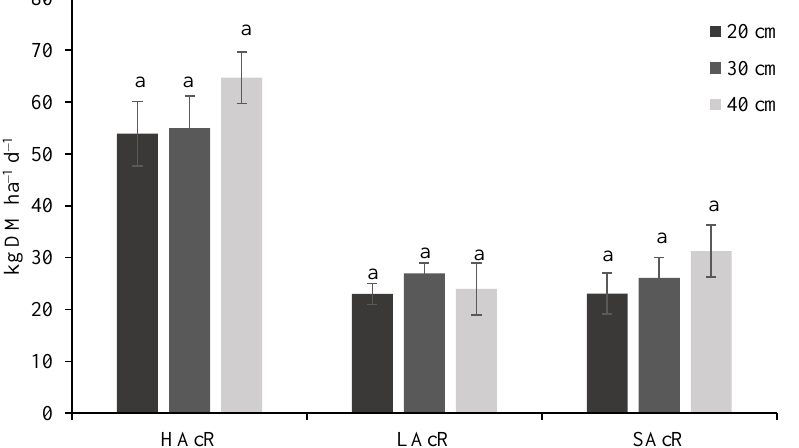
Figure 2. Average herbage (HAcR), leaf (LAcR), and stem accumulation rate (SAcR; kg DM ha −1 d −1 ) of tangolagrass pastures subjected to different pre-grazing height targets (20, 30, or 40 cm) and the same intensity of defoliation (40% of the initial height). Vertical error bars correspond to the standard error of the mean (SEM). For each variable, means followed by the same letter do not differ by the Tukey – Kramer test ( p < 0.05). Table 3. Average tiller population density (tillers m −2 ; TPD), and pre- and post-grazing leaf area index (LAI pre and LAI post, respectively) of tangolagrass pastures subjected to different pre-graz- ing height targets (20, 30, or 40 cm) and the same intensity of defoliation (40% of the initial height). Height (cm) Variable SEM 20